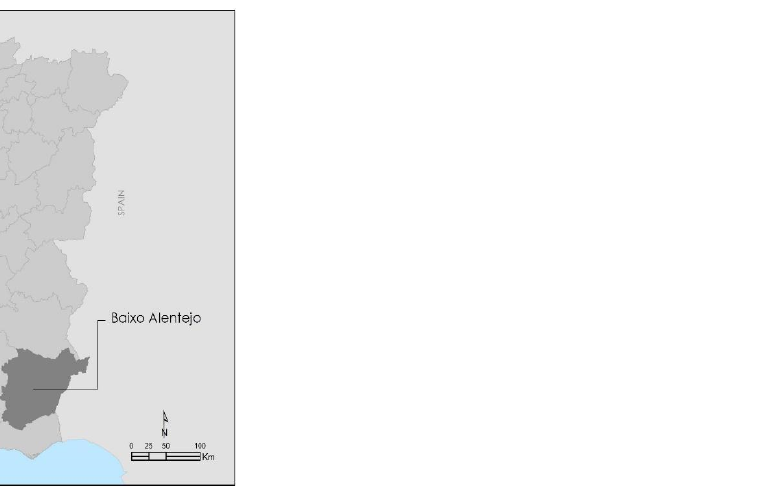
Figure 3. Map of the NUTS III region Baixo Alentejo. Sources: author’s own elaboration based on Eurostat (2019).